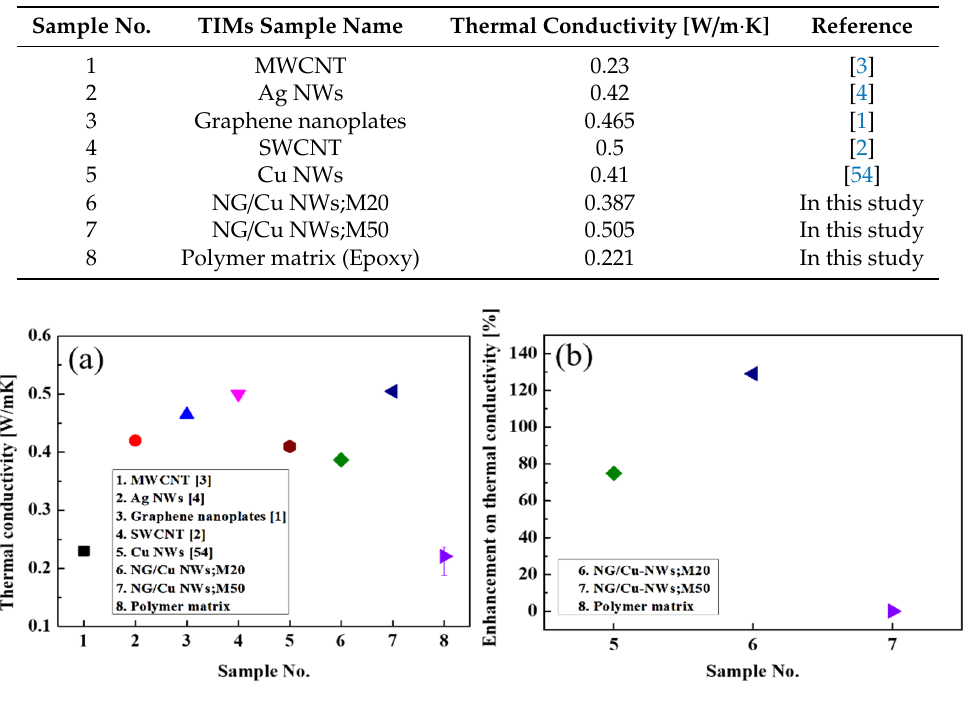
Figure 6. ( a ) Thermal conductivity of the two TIMs used in this study and the TIMs of other